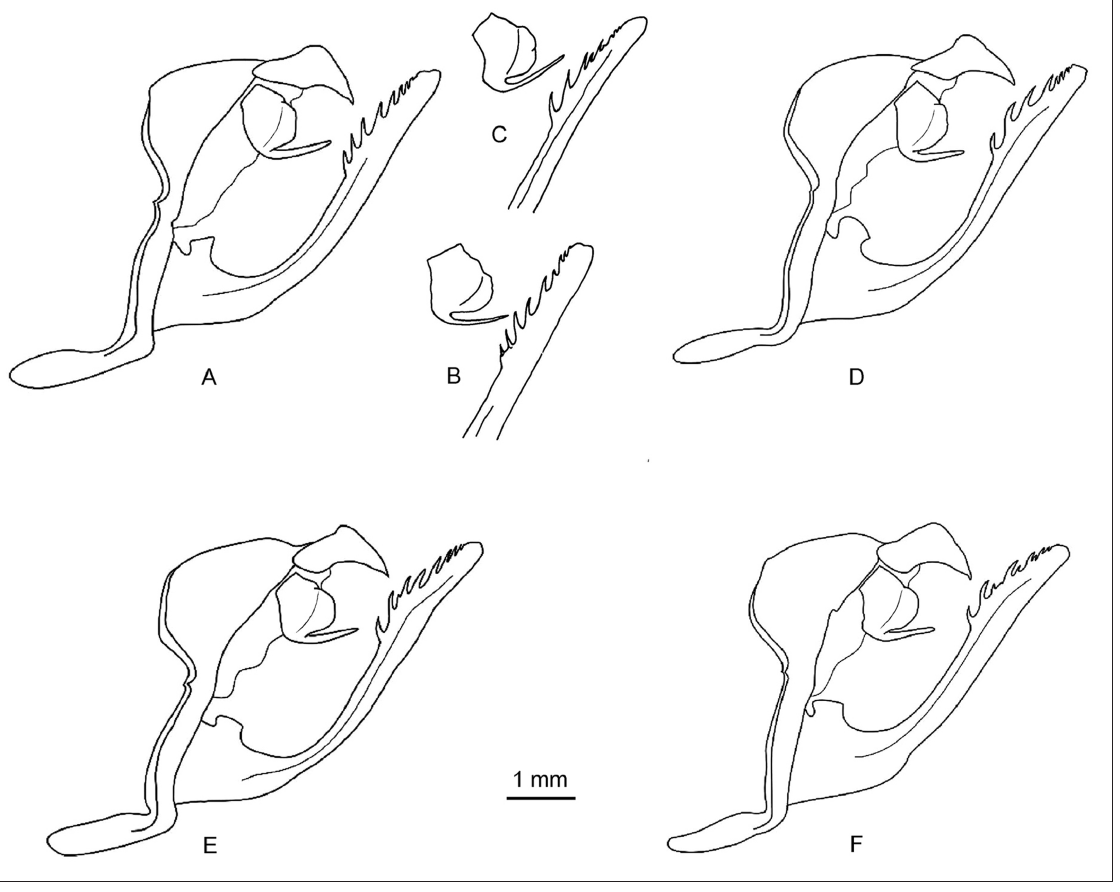
Fig. 14. A-C . Male genitalia of Eryphanis zolvizora reyi ssp. nov. A . PT from La Mina, Barinas, Venezuela (R, 115-JCSC). B . PT from San Isidro, Barinas, Venezuela (MNHN, PBB 2324). C . PT from Charalá, Santander, Colombia (MNHN, PBB 2321). D-F . Male genitalia of Eryphanis